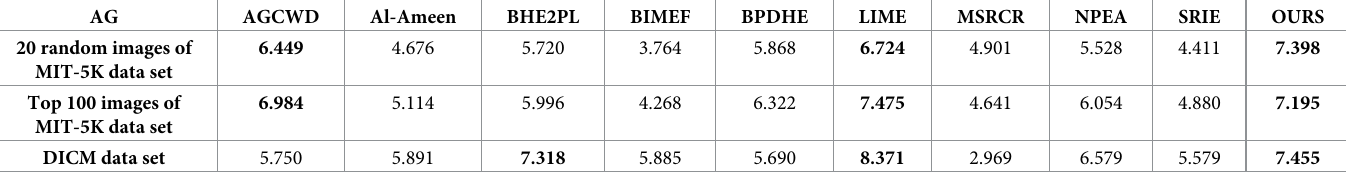
Table 10. Average image average gradient values of three groups of